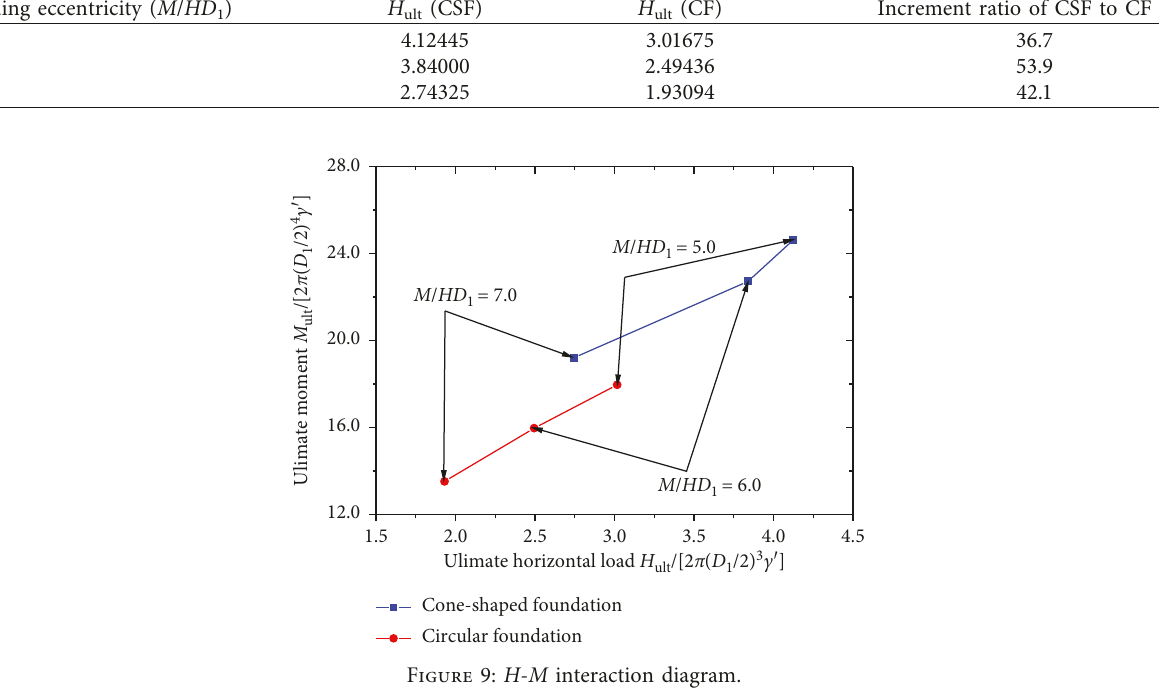
Table 2: Ultimate bearing capacity for the CSF model and CF model under various loading eccentricities. Loading eccentricity ( M / HD 1 )